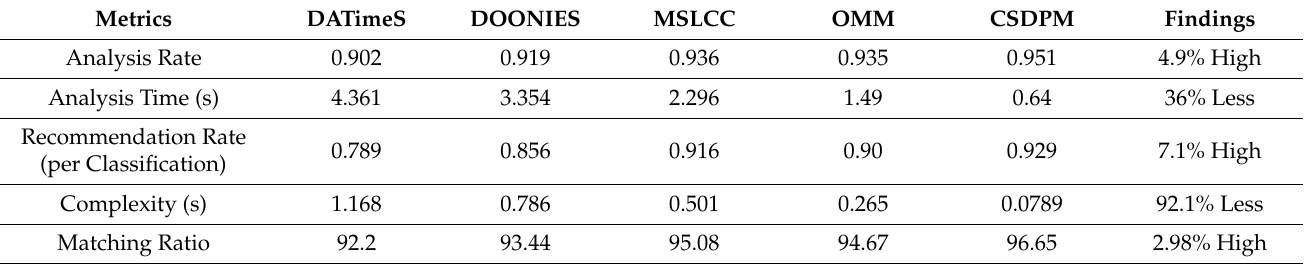
Table 2. Comparative analysis of